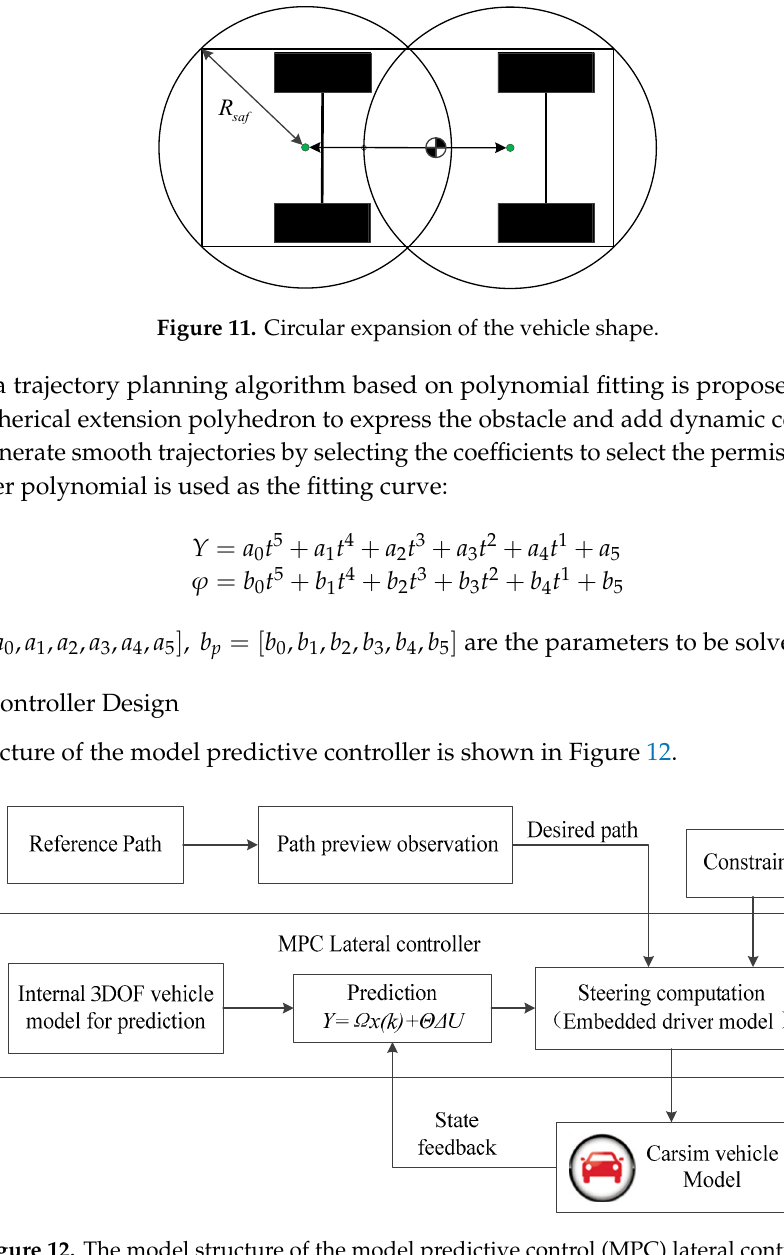
Figure 12. The model structure of the model predictive control (MPC) lateral controller.